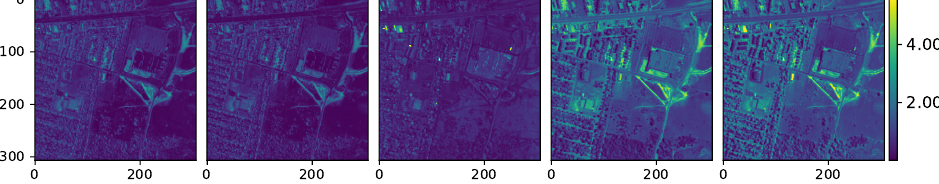
Figure 12. Energy of the nonlinear components of the Urban data. From left to right: VCA-K-Hype, N-FINDR-NDU, rNMF, DAEN and the proposed method,